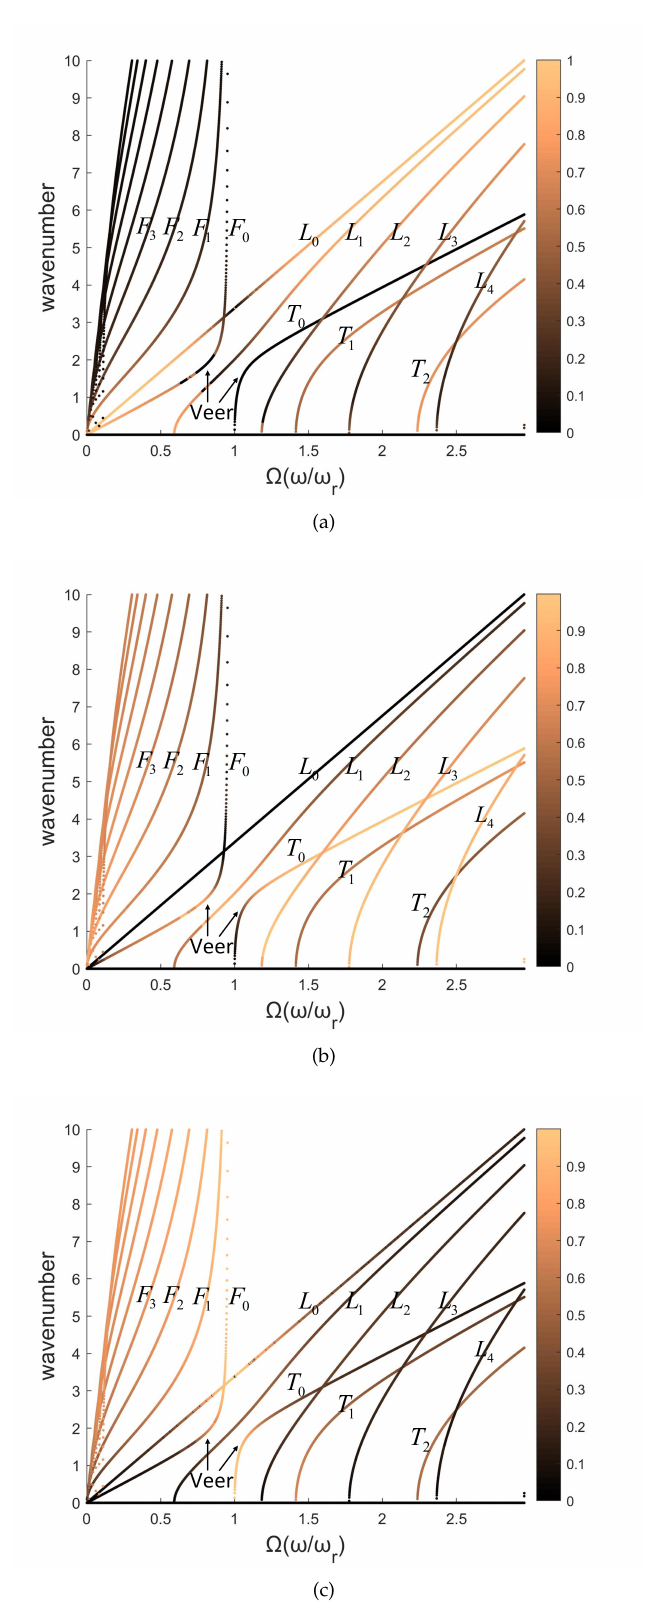
Figure 10. Amplitudes in Equation (16): ( a ) A n , ( b ) B n , and ( c ) C n of an n -order wave mode. These amplitudes represent the weights of wave-shapes of L n , T n , F n , and are normalized by A 2 n + B 2 n + C 2 n =